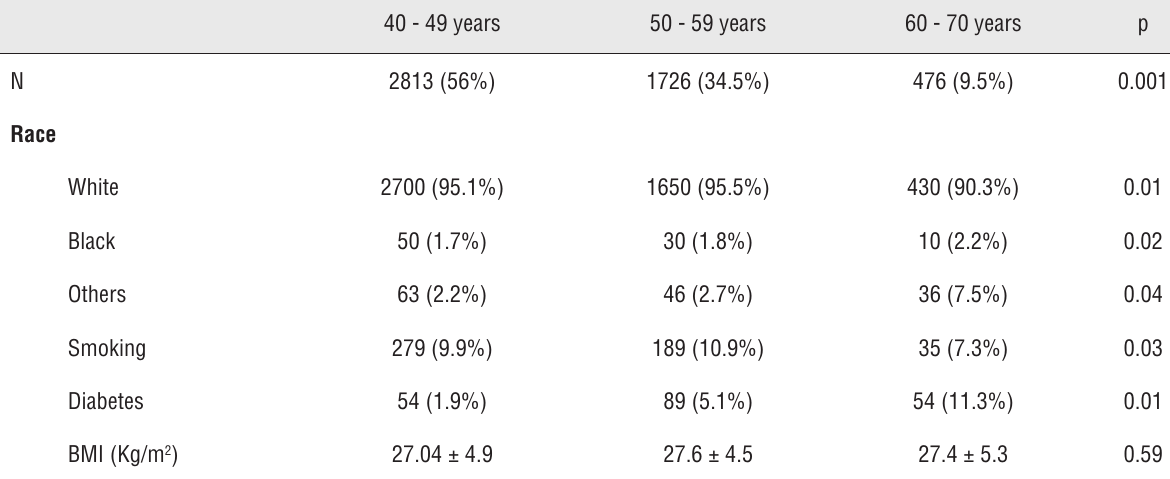
Table 1 - Demographic data of 5015 men.